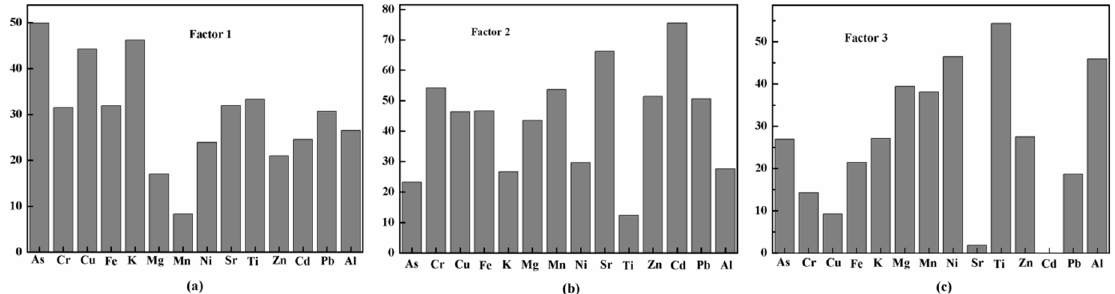
Figure 4. Source profiles obtained from the positive matrix factorization (PMF) model. ( a ) Factor 1 agricultural sources; ( b ) Factor 2 industrial sources; ( c ) Factor 3 geogenic sources.